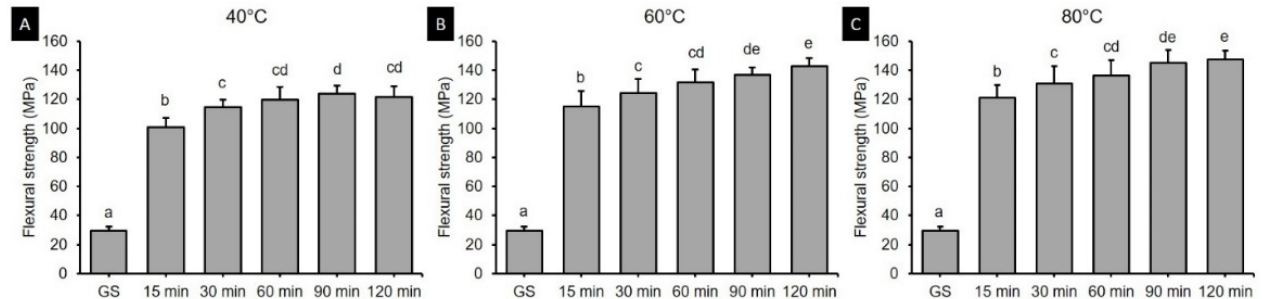
Figure 4. Results from one-way ANOVA. Flexural strength according to postcuring time for each postcuring temperature. ( A ) 40 °C ( B ) 60 °C and ( C ) 80 °C. Data are mean and standard-deviation values of 3D printed specimens. Different lowercase letters indicate a significant difference in the same group.